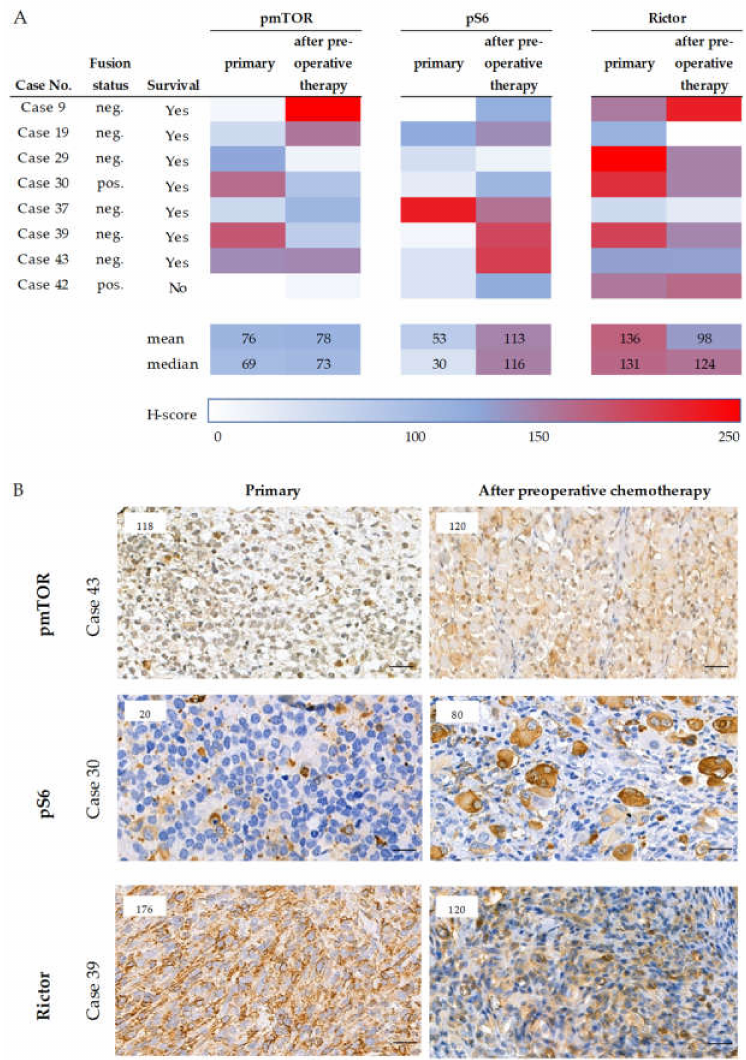
Figure 2. Expression of mTOR markers in paired samples (primary and pretreated). The H-score of mTOR related markers of the paired (primary and pretreated) cases are presented (panel ( A )). The color scale labels the magnitude of the H-scores in each case. Survival data and the fusion status are also given. Under the table ( A ), representative pmTOR, pS6, and Rictor immunohistochemical stainings of primary and pretreated RMS cases are shown (panel ( B )). DAB (brown) and hematoxylin were used as chromogen and counterstaining, respectively. The numbers in the left upper corner of the pictures refer to the given H-scores. Pictures were taken with CaseViewer 2.3 software (3DHistech Ltd., Budapest, Hungary). The scale bars show 25 µ